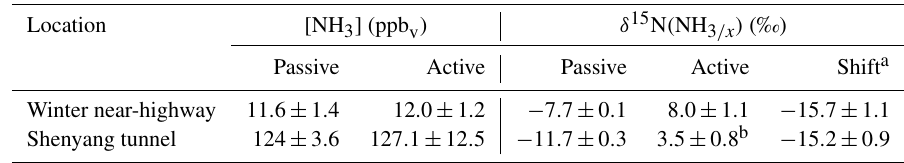
Table 4. Summary of [ NH 3 ] and δ 15 N ( NH 3 ) from the passive and active collection of NH 3 at the winter near-highway and Shenyang stationary monitoring